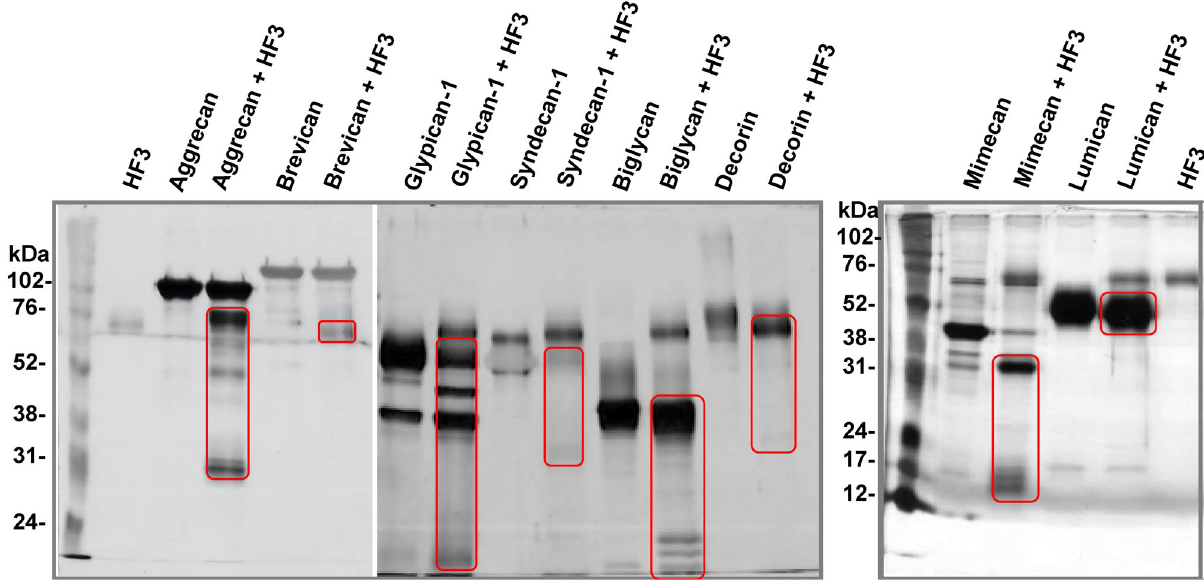
Figure 2. Activity of HF3 upon proteoglycans in vitro. Proteoglycans were incubated with HF3, as described in “Materials and methods”, and submitted SDS-PAGE. Proteins were stained with silver. Red rectangles indicate main degradation